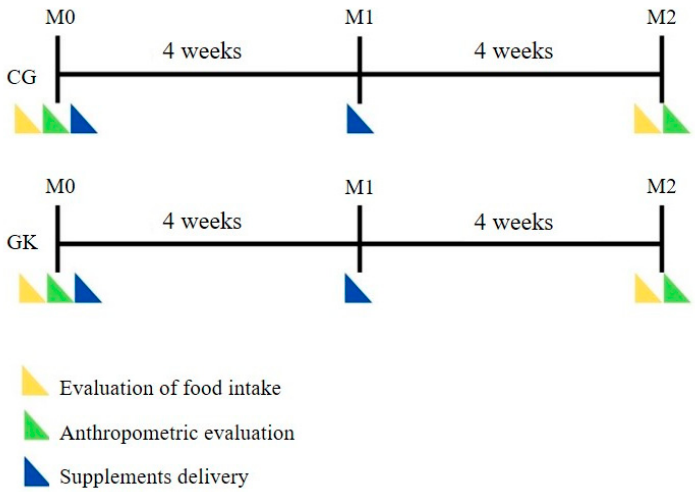
Figure 2. Experimental draft for both groups. M0: Initial screening; M1: Last supplements delivery; M2: Final evaluation. CG: Control group; GK: Krill oil group.